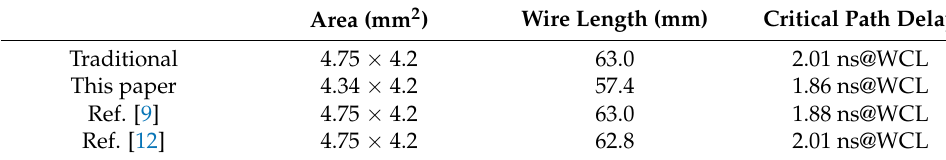
Figure 6. SRAM placement in co-operative methodology.